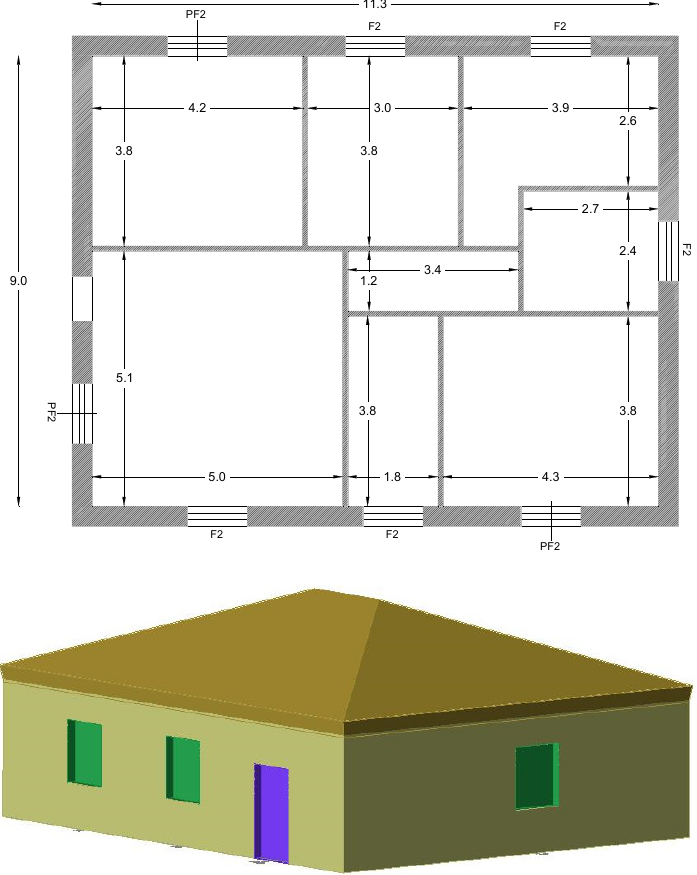
Figure 7. Map and 3D view of the chosen case study.